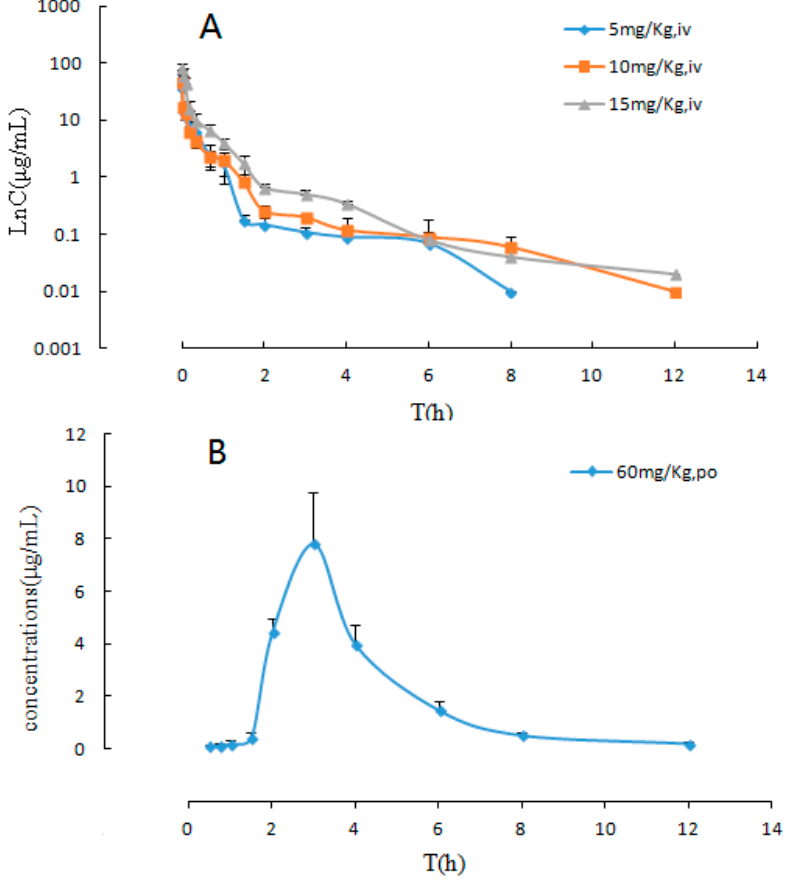
Figure 4. Logarithm-transformed concentration-time (LnC-T) profiles and mean plasma concentration-time profiles of sodium danshensu (each point represents mean ± SD). ( A ) LnC-T profiles after intravenous administration of sodium danshensu at doses of 5, 10, and 15 mg/kg in beagle dogs; ( B ) mean plasma concentration-time profile after oral administration of sodium danshensu at a dose of 60 mg/kg in beagle dogs. Table 5. Mean pharmacokinetic parameters after intravenous and oral administration of sodium danshensu in 24 beagle dogs.